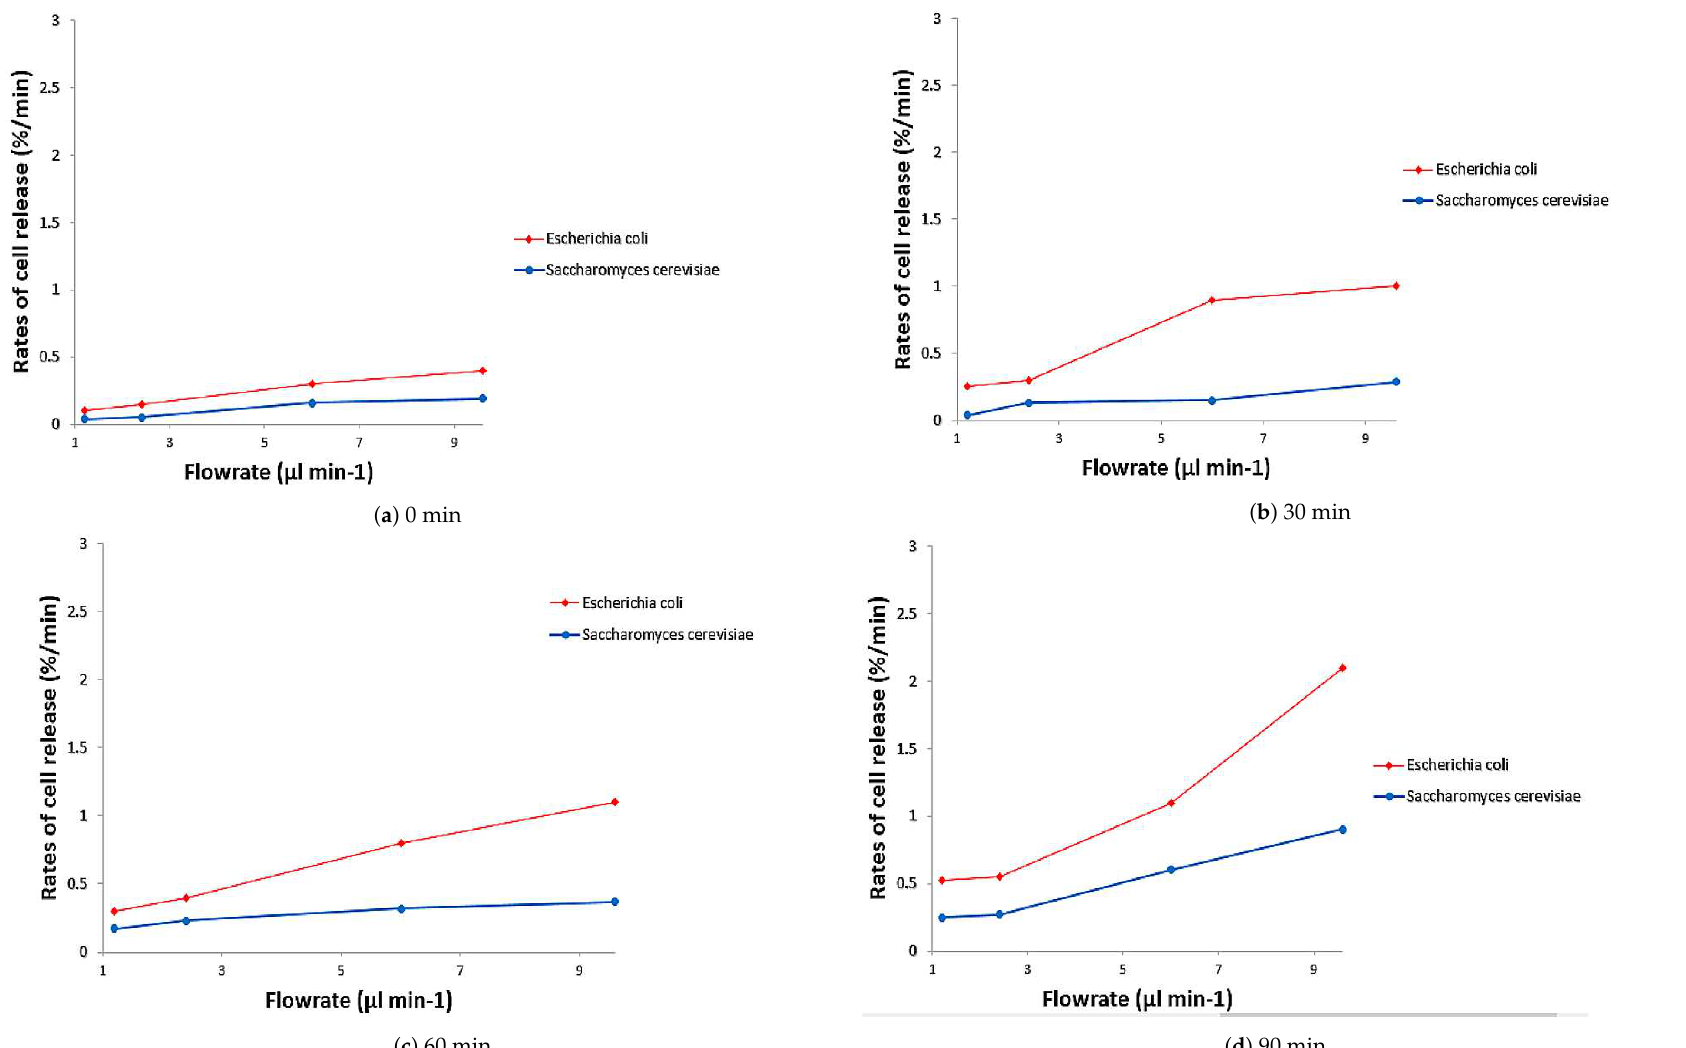
Figure 9. Comparison of the rate of release of E. coli and S. cerevisiae cells from the microelectrode at different flow rates and pulsing